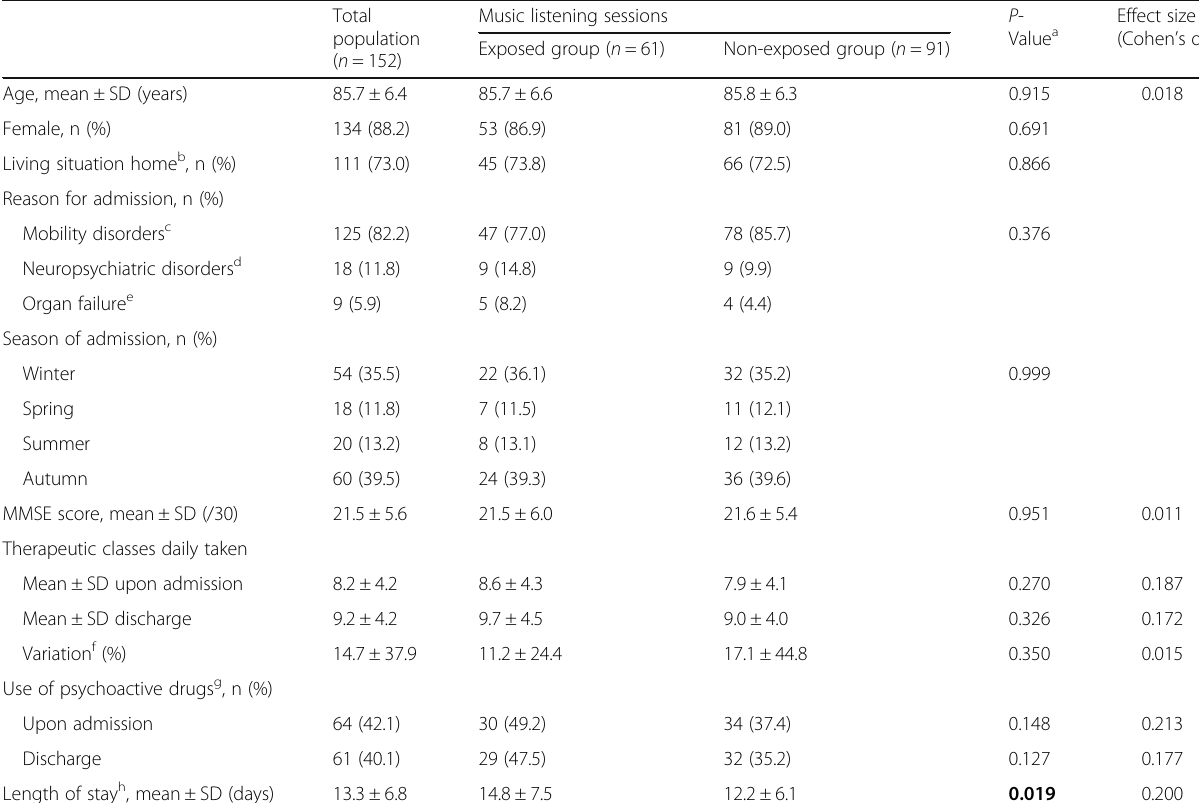
Table 1 Baseline characteristics of participants who were exposed and non-exposed to the music listening sessions ( n =